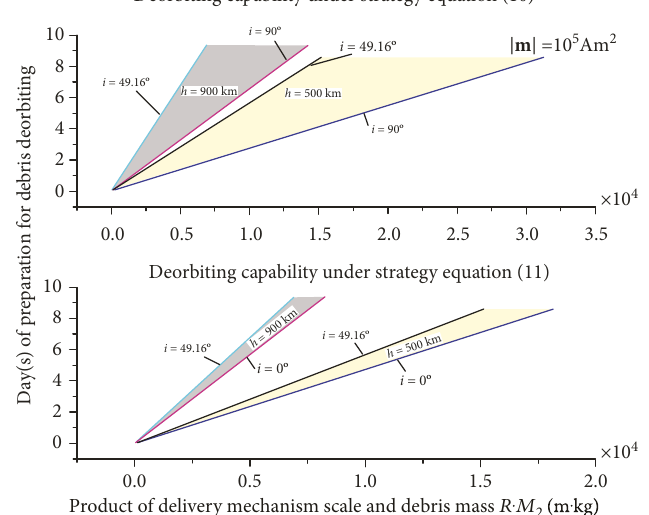
Figure 15: Deorbiting capability under strategy equations (10) and